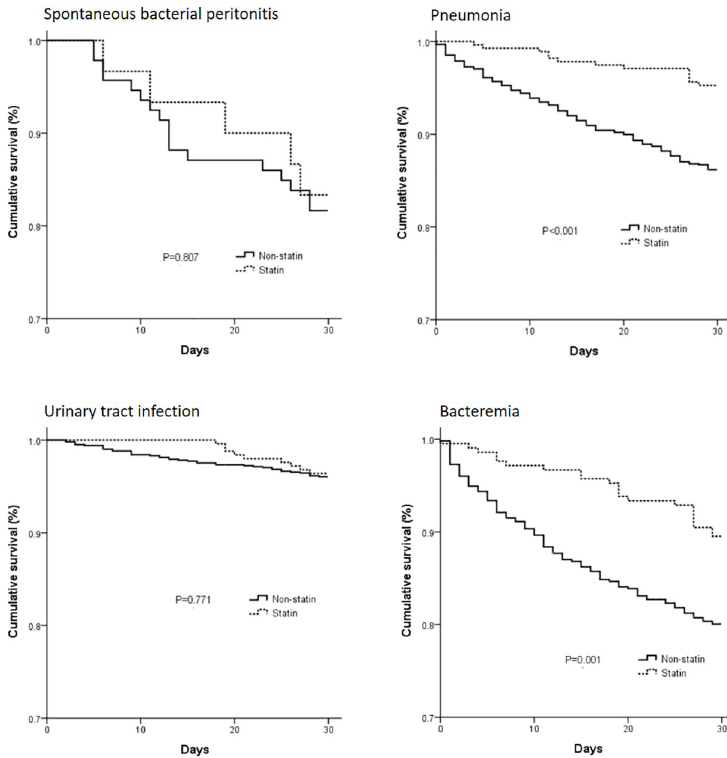
Fig 2. Kaplan–Meier survival analysis of 30-day mortality of cirrhotic patients with different bacterial infections.